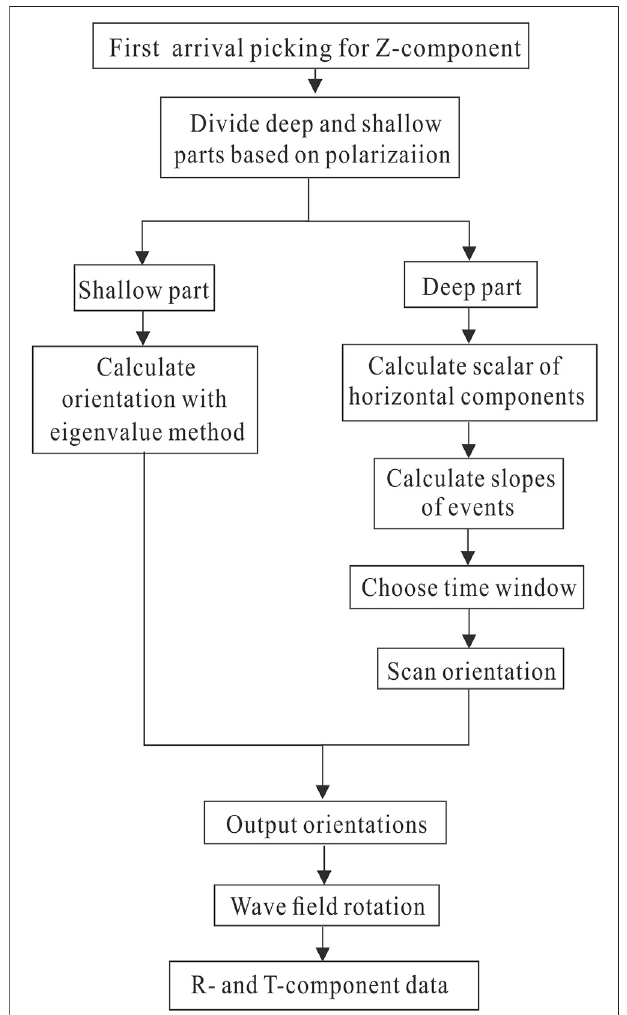
FIGURE 1 | Flowchart of the scalar fi eld method for determining geophone